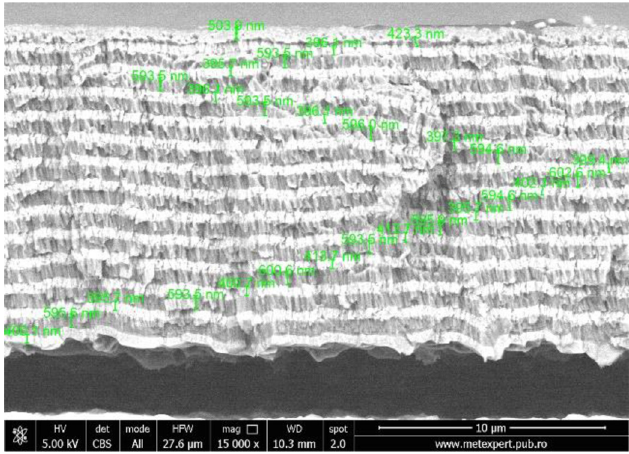
Fig. 2. SEM picture of EB-PVD multi-layered Ti-Al nanos- tructured coatings with periodical thickness of each fi lm in the range 400 –